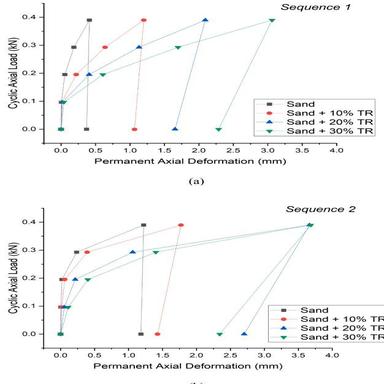
(a) and (b): Permanent axial deformation at the end of sequence 1 and sequence 2 of cyclic axial loading from repeated load test.